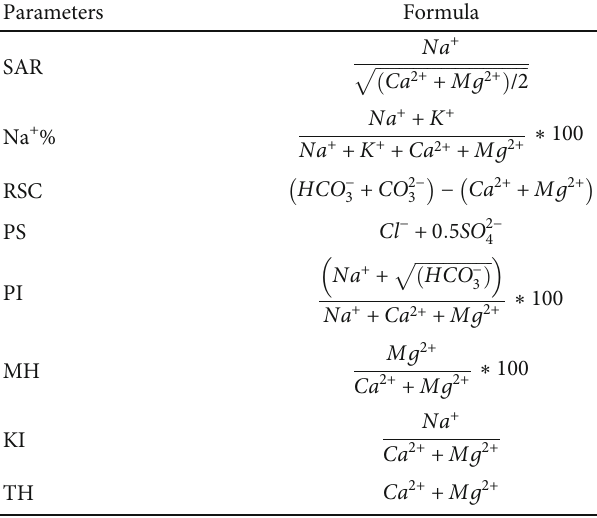
Table 4: Irrigation water quality evaluation